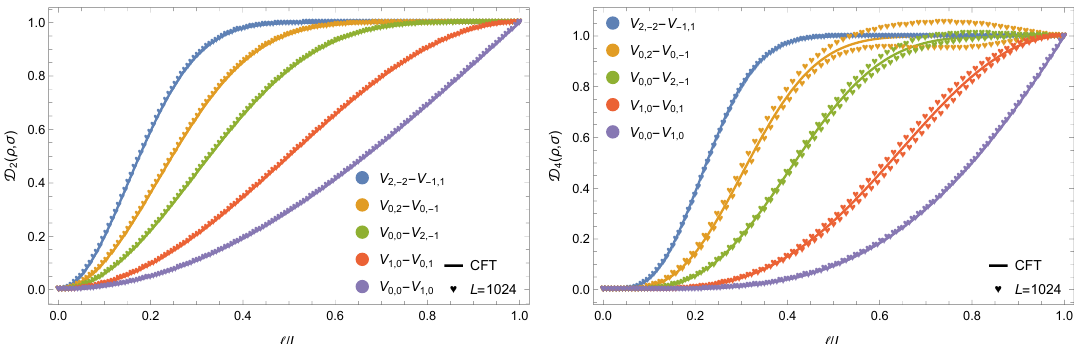
Figure 3 . Even n -distance D n [(cid:1) (cid:11) ] for n = 2 ; 4 as a function of the ratio between the subsystem ‘ and the system size L in the free compact boson theory. The solid lines are the exact CFT predictions in (4.25). The symbols are the numerical data for a system of size L = 1024 and arbitrary ‘ . Di(cid:11)erent colours correspond to di(cid:11)erent pairs of vertex states (cid:26) and (cid:27) (several values of (cid:1) (cid:11) are